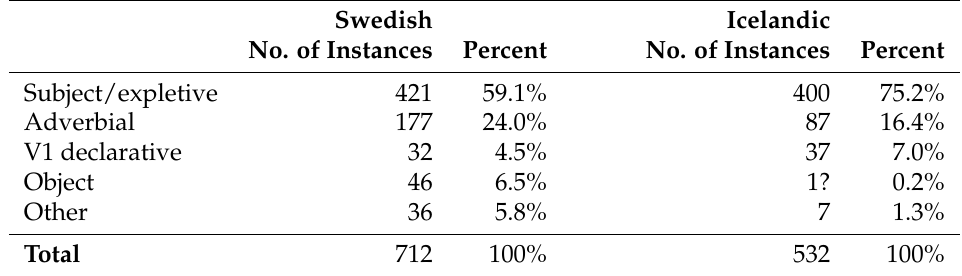
Table 1. Grammatical function of phrases in the prefield in NDC, from Lindahl (under